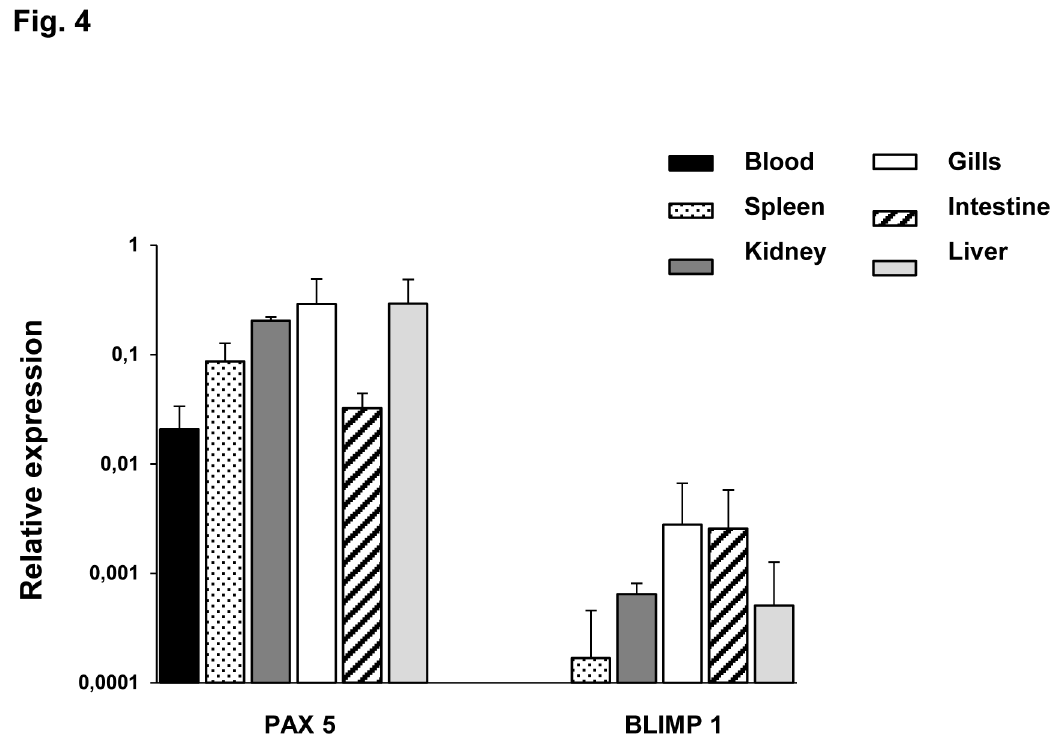
Figure 4. Levels of Pax5 and Blimp1 transcription in sorted IgM + cells. Constitutive levels of transcription of Pax5 and Blimp1 in IgM + cells from different trout tissues. Levels of transcription were evaluated through real time PCR in duplicates. Data from 3 independent experiments are shown as the mean gene expression relative to the expression of an endogenous control (EF-1α) ±